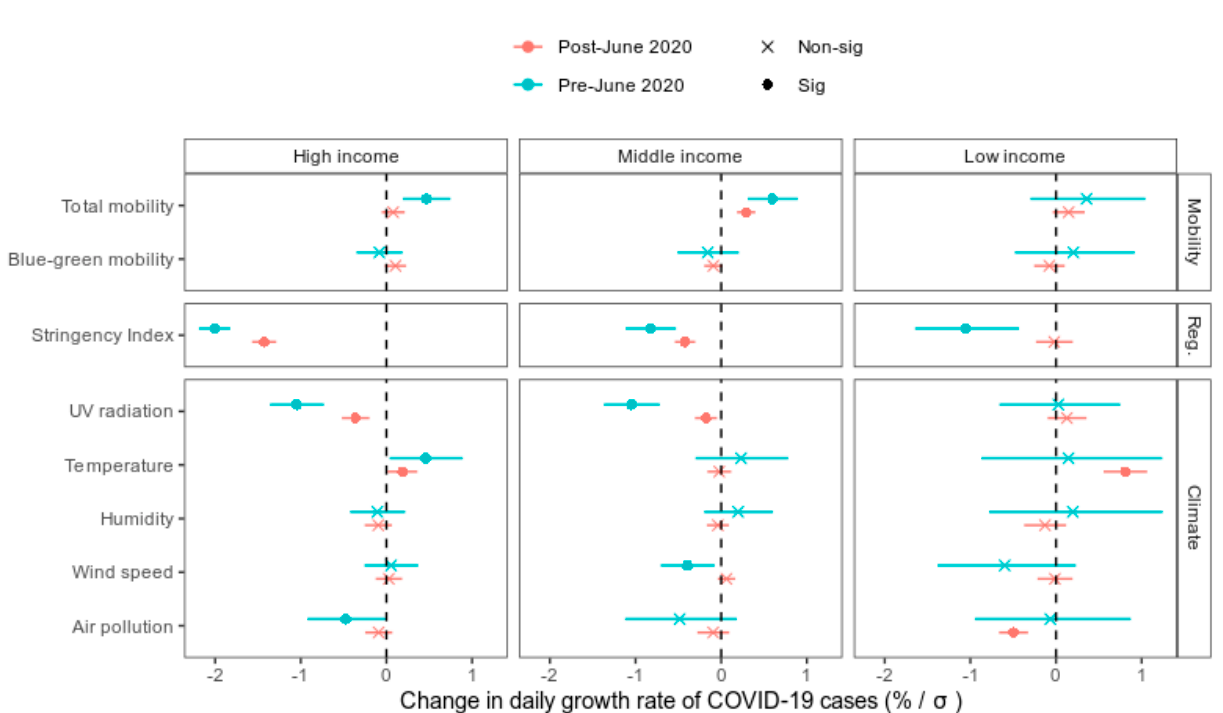
Figure 2. Empirical estimates of the association between COVID-19 growth rates and mobility, restrictions and environ- mental conditions. The cumulative effect of each predictor variable is derived from mixed-effects linear regression models built for high-, middle- and low-income countries, pre- and post-June 2020. Points and lines represent the model estimates and 95% confidence intervals. Non-significant (“non-sig”) estimates are marked with an “x” whereas significant (“sig”) estimates are marked with a solid point. Estimates are expressed as percentage changes in daily COVID-19 cases per standard deviation ( δ ) increase in the predictor variable.